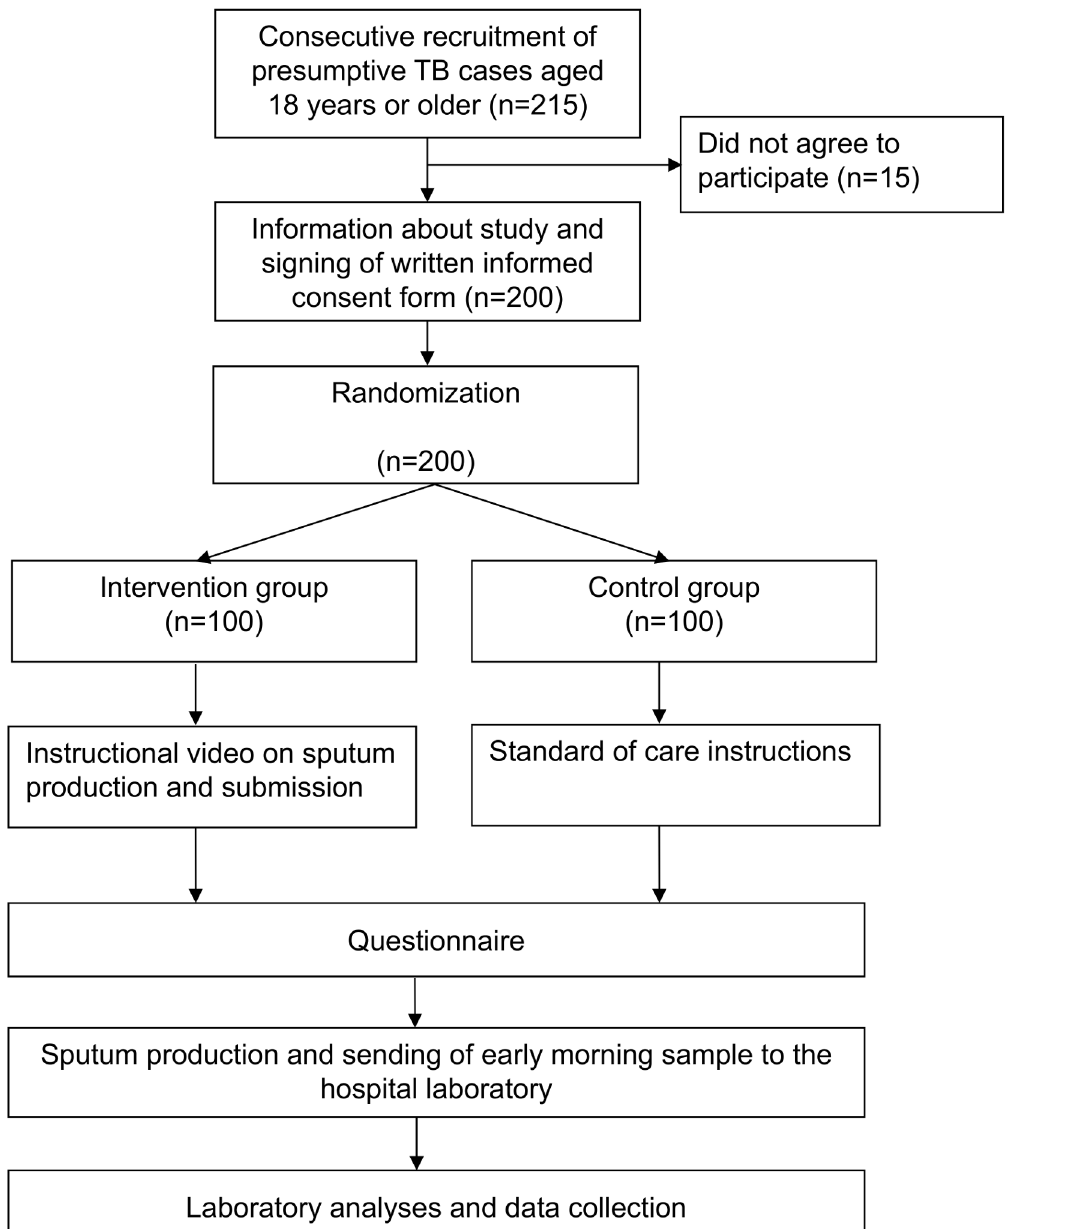
Fig 2. Overview of the study